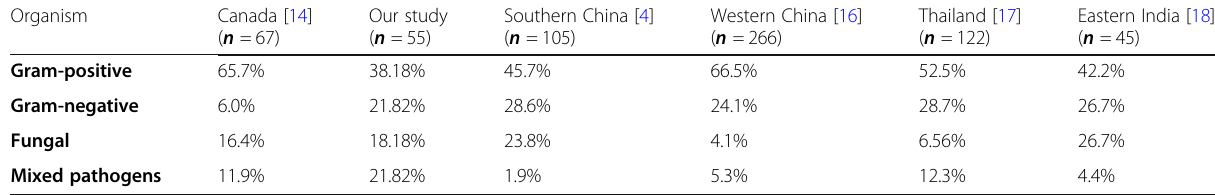
Table 8 Microbiologic profile compared to other countries. Our study showed a lower proportion of Gram-positive bacteria, less fungal infections compared to India and southern China, and a higher proportion of mixed pathogen infections Organism